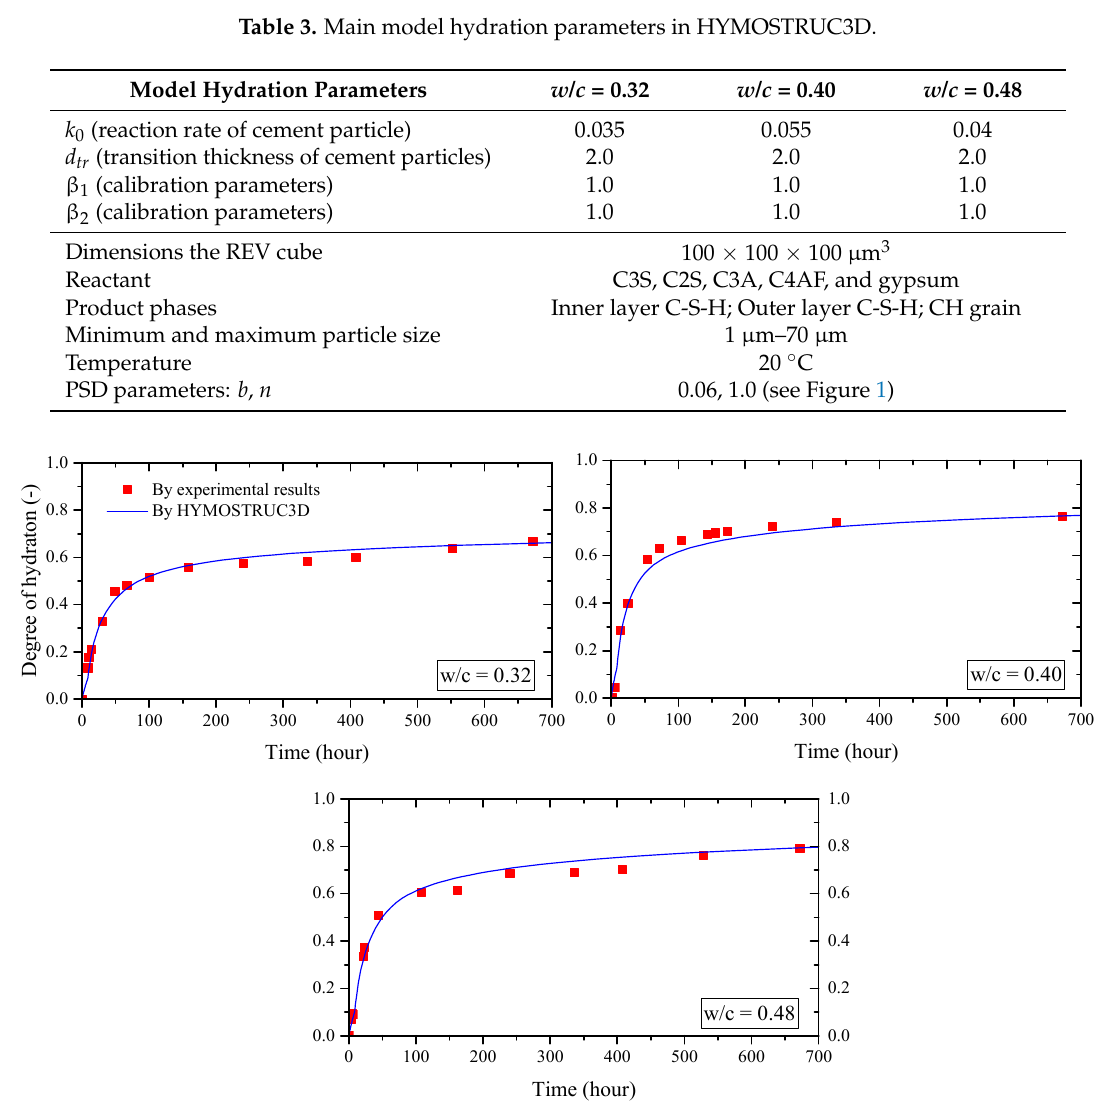
Figure 4. The degree of hydration predicted by HYMOSTRUC3D and measured by isothermal calorimetry.